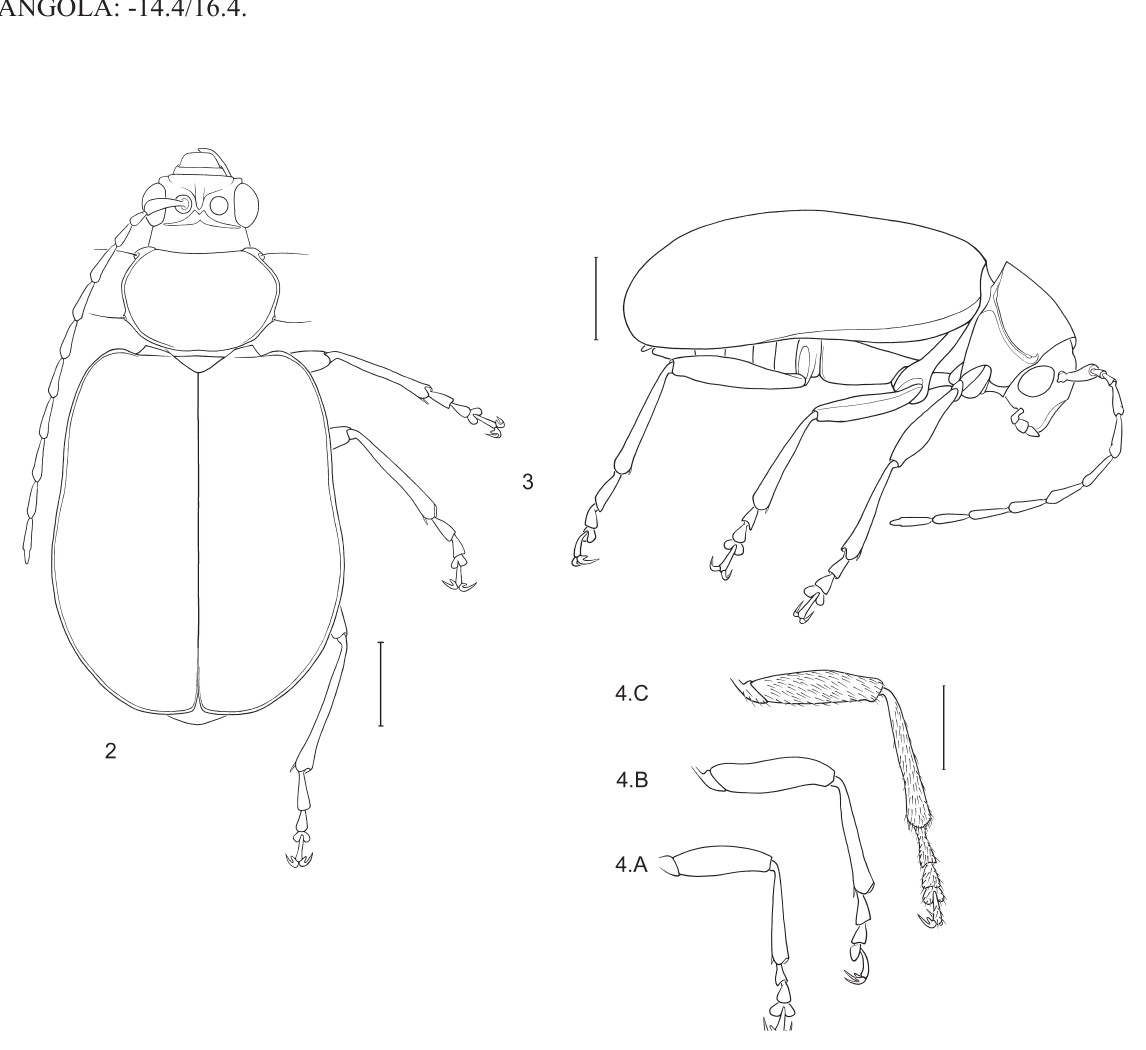
Figs 2-4. Oosagitta angolensis comb. nov. 2 . Habitus, semi-schematic dorsal view, ♀. 3 . Habitus, lateral view, ♀. 4 . Legs: A. Prothoracic leg. B . Mesothoracic leg. C . Metathoracic leg. Scale bars = 1